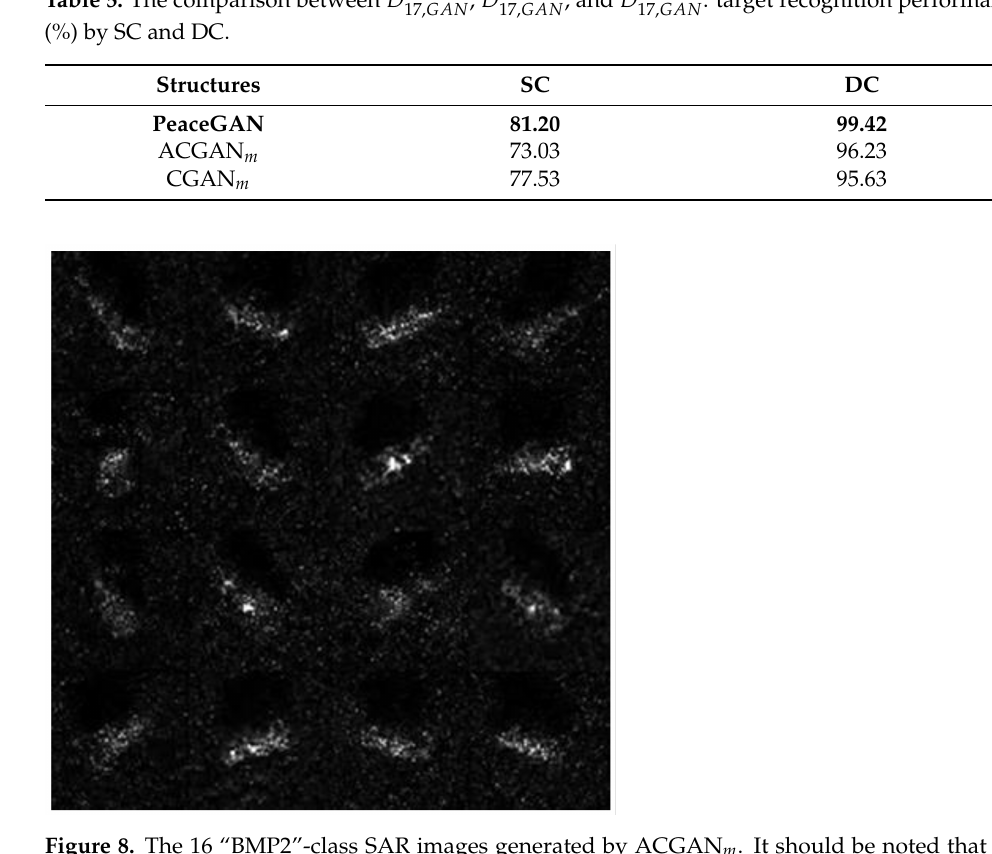
, D AC , and D C : target recognition performance 17, GAN 17, GAN 17, GAN